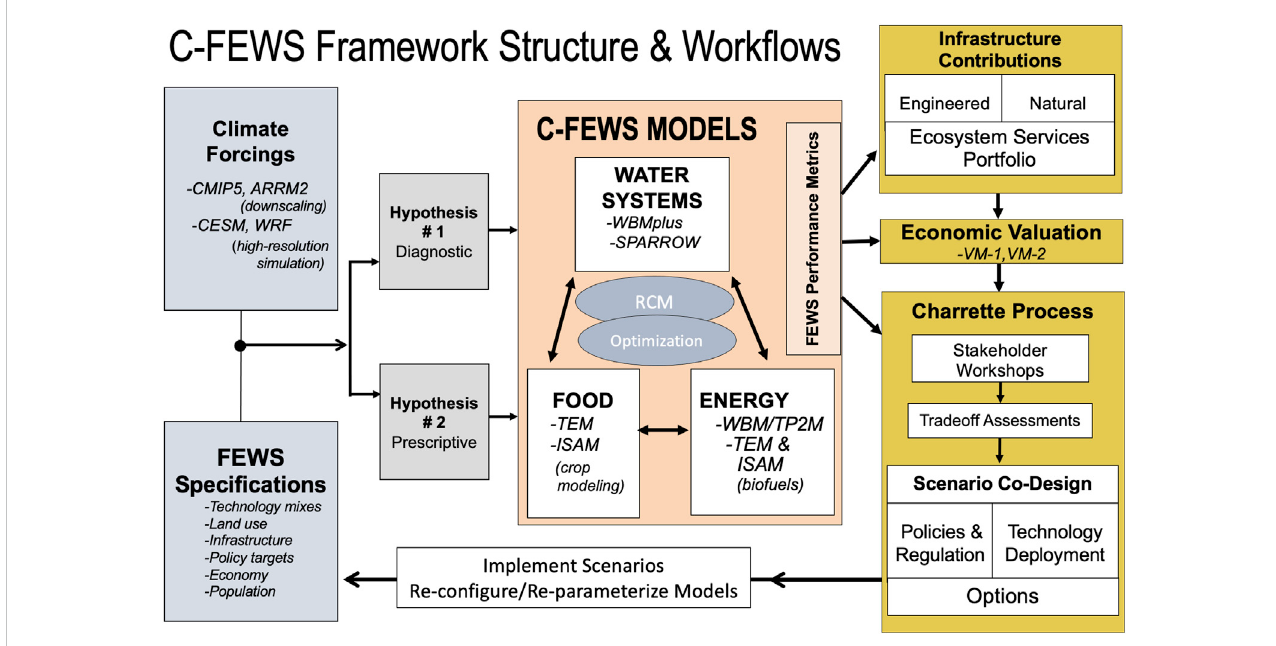
FIGURE 1 Key elements of the C-FEWS model suite, their connections, and the overall organizing